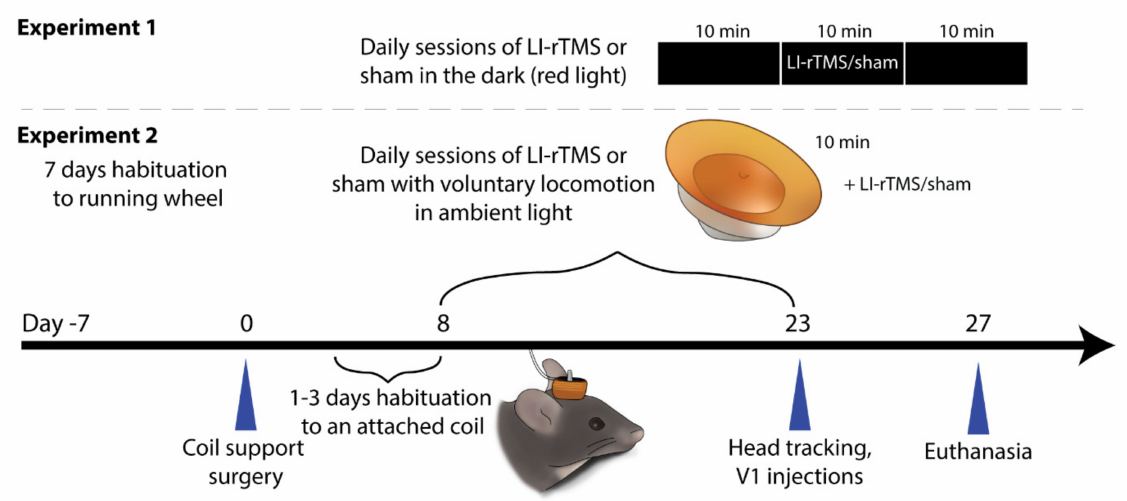
Figure 4. Experimental timeline of the current study. Adult ephrin-A2A5 -/- mice were divided into two environmental conditions. In Experiment 1, the mice were able to freely move in a dark environment and in Experiment 2, they were given free access to a running wheel in ambient light. In both experiments, the mice received either LI-rTMS or sham for 14 daily 10 min